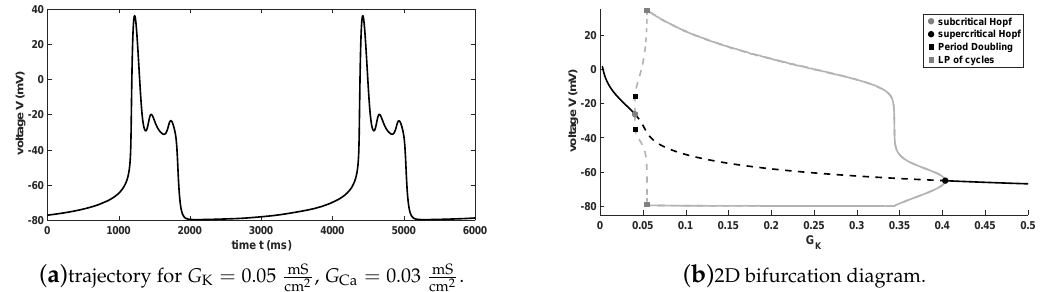
Figure 6. Bifurcation diagram of (1) for the case G Ca = 0.03 mS